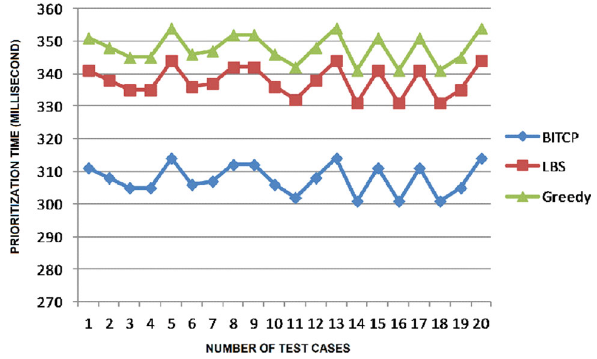
Fig. 14 A closer view of the prioritization time